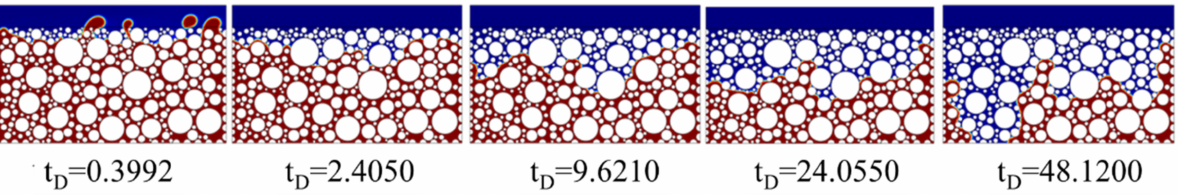
Figure 20. Oil-water distribution at different times with σ = 5 mN/m.